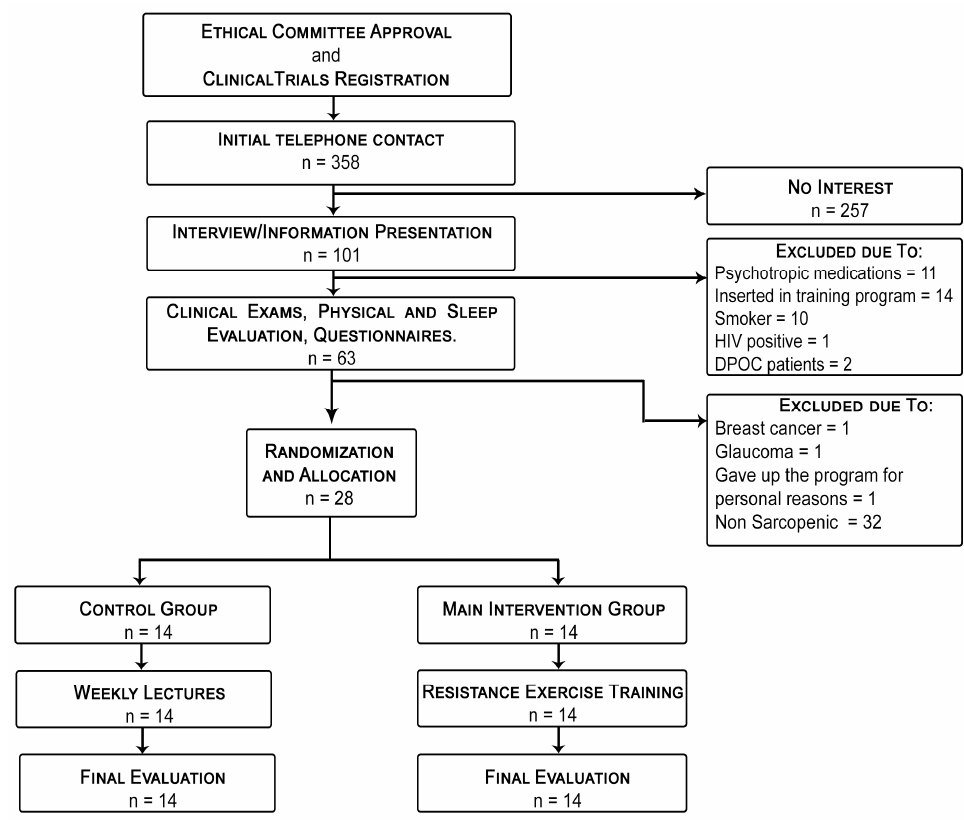
Figure 1. Study flow diagram.